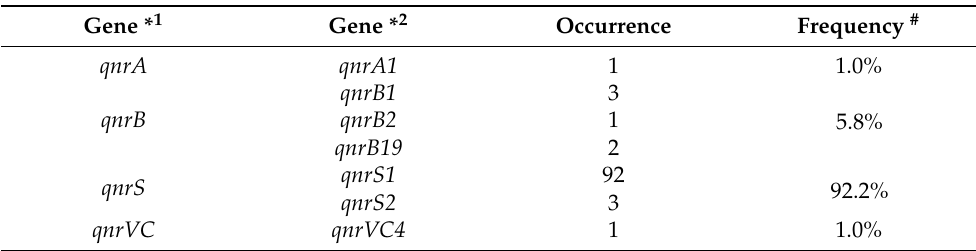
Table 1. Occurrence and frequencies of determined qnr genes within qnr -carrying, (fluoro)quinolone- resistant E. coli isolates.